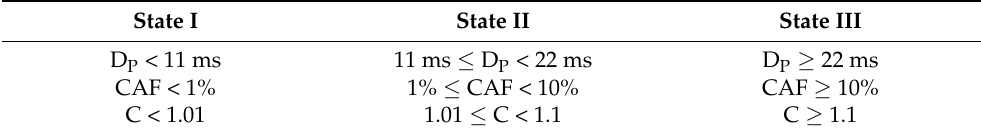
Table 1. Congestion state and thresholds.